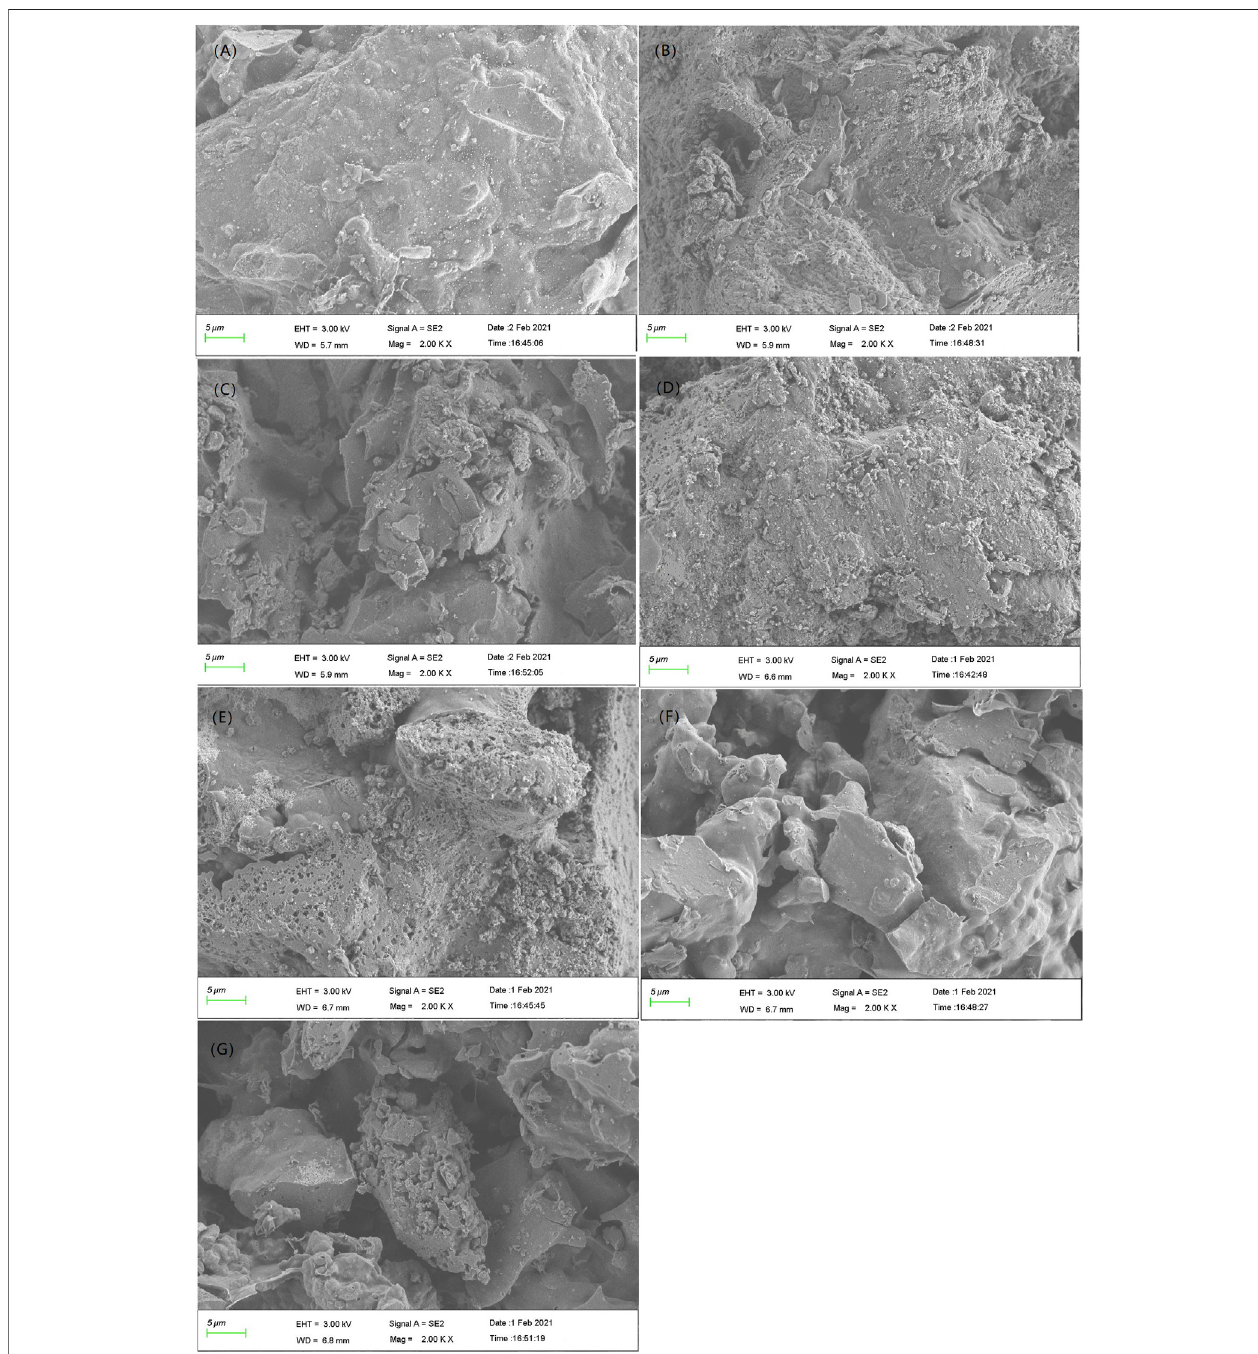
FIGURE 11 | SEM images of the three adsorbent materials. (A) BC without adsorption of Pb 2+ ; (B) CTS-BC without adsorption of Pb 2+ ; (C) BC-CTS without adsorptionofPb 2+ ; (D) adsorptionofPb 2+ bytheCTS-BCatpH (cid:1) 3; (E) adsorptionofPb 2+ bytheCTS-BCatapH (cid:1) 7; (F) adsorptionofPb 2+ bytheBC-CTSatpH (cid:1) 7; and (G) adsorption of Pb 2+ by the BC-CTS at pH (cid:1) 9.